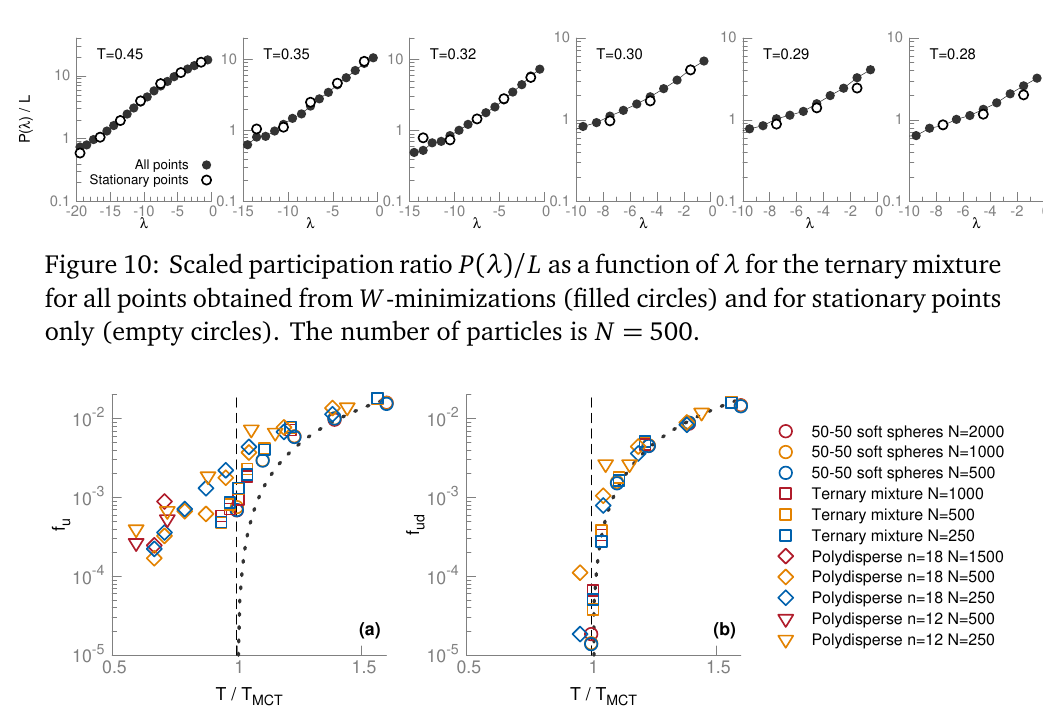
as a function of T / T for stationary u MCT